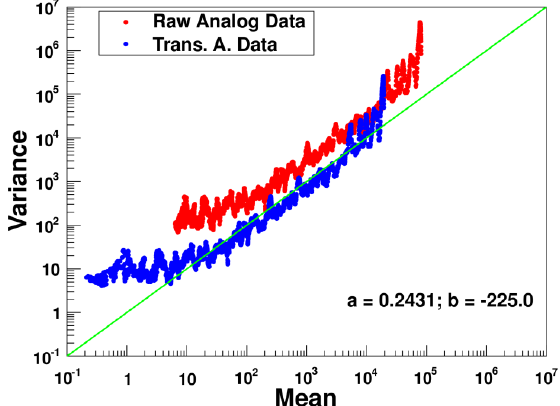
Figure 11. Spatial variances of lidar analog data and its corresponding transformed photon-counting data for determination of the transfer coefficients of a and b .